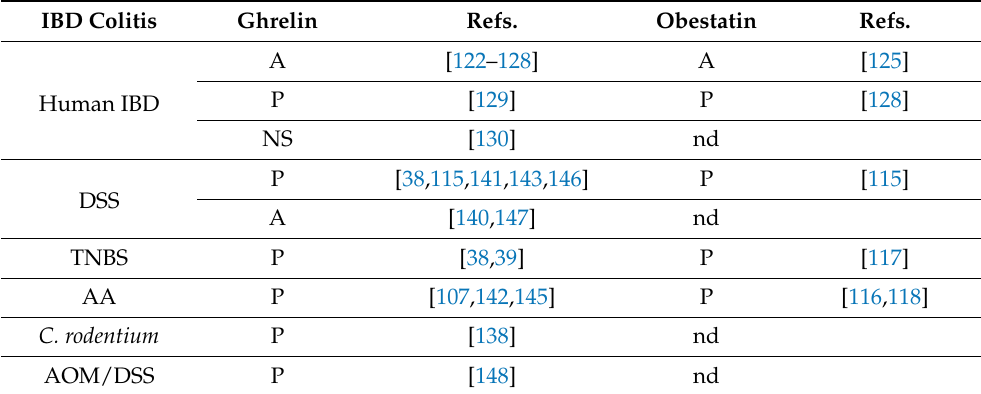
Table 2 provides a short summary of the potential role of ghrelin and obestatin in IBD colitis. Table 2. Summary of the Role of Ghrelin and Obestatin in Different Models of Inflammatory Bowel Disease. IBD Colitis Ghrelin Refs. Obestatin